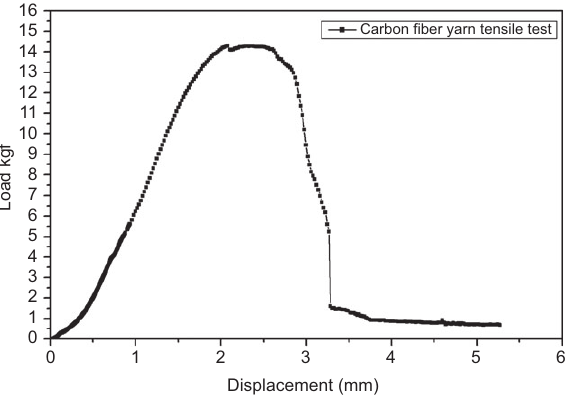
Figure 4 Load-displacement curve of the carbon fiber